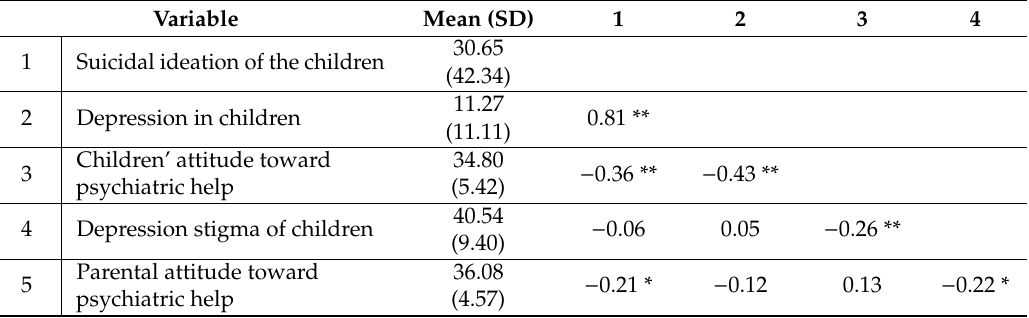
Table 2. Correlations among variables ( n = 103 parent-child pairs)